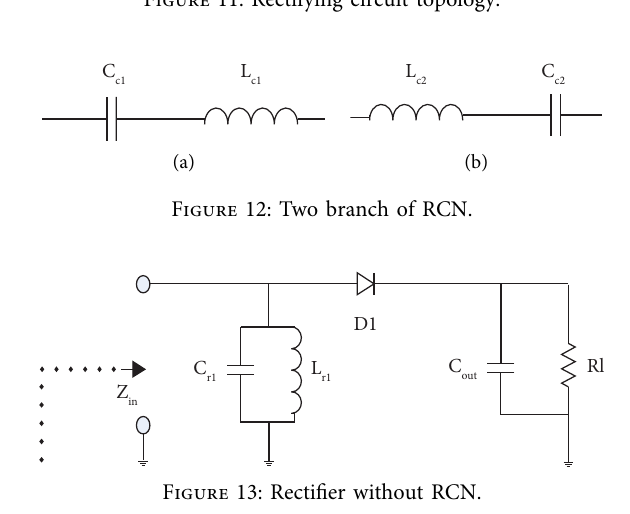
Figure 13: Rectifer without RCN.